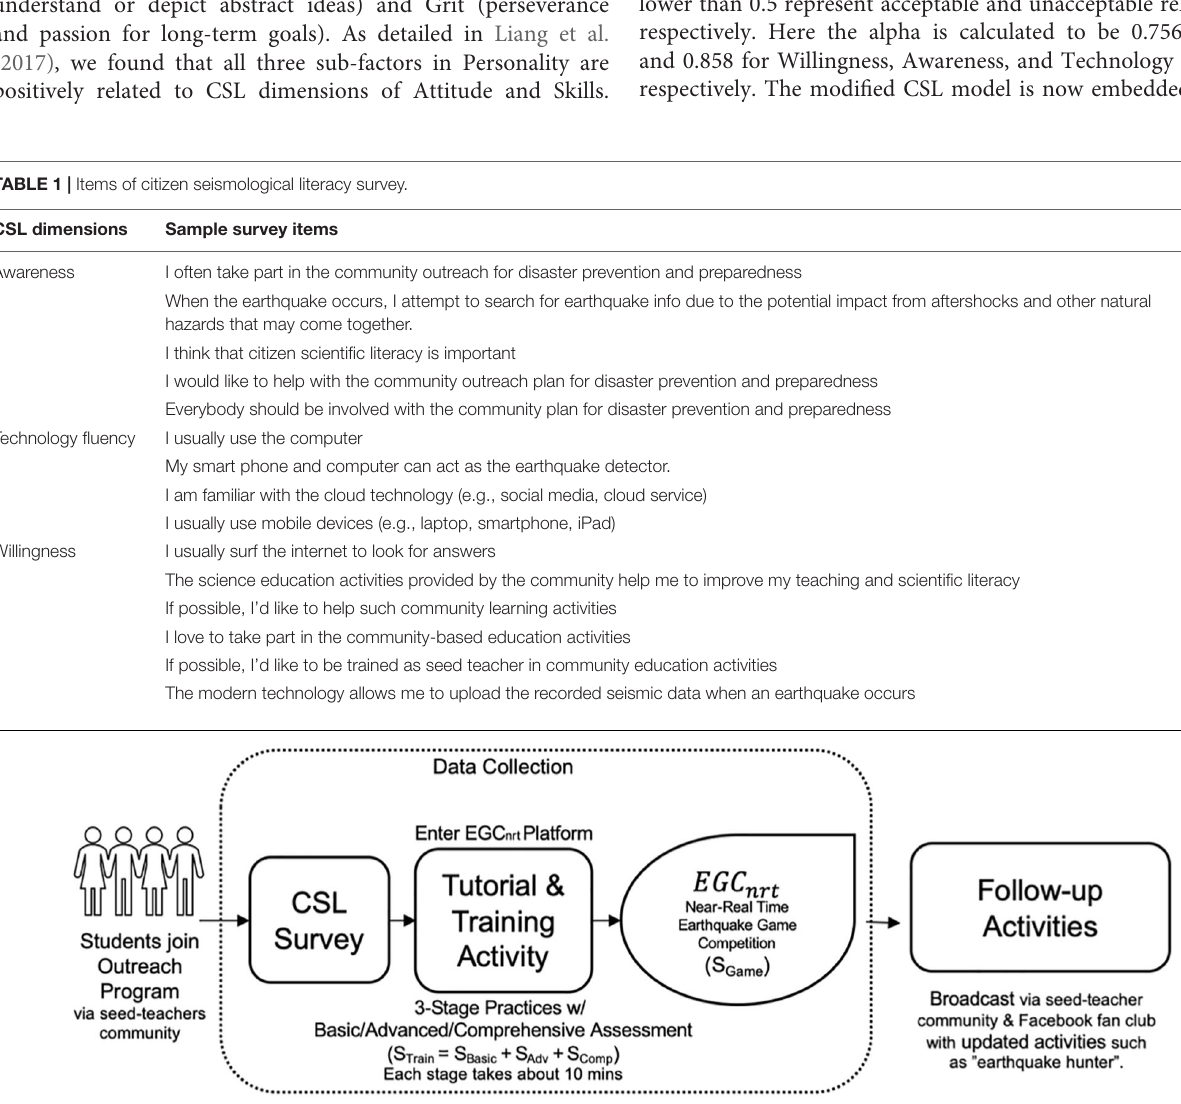
Frontiers in Earth Science |